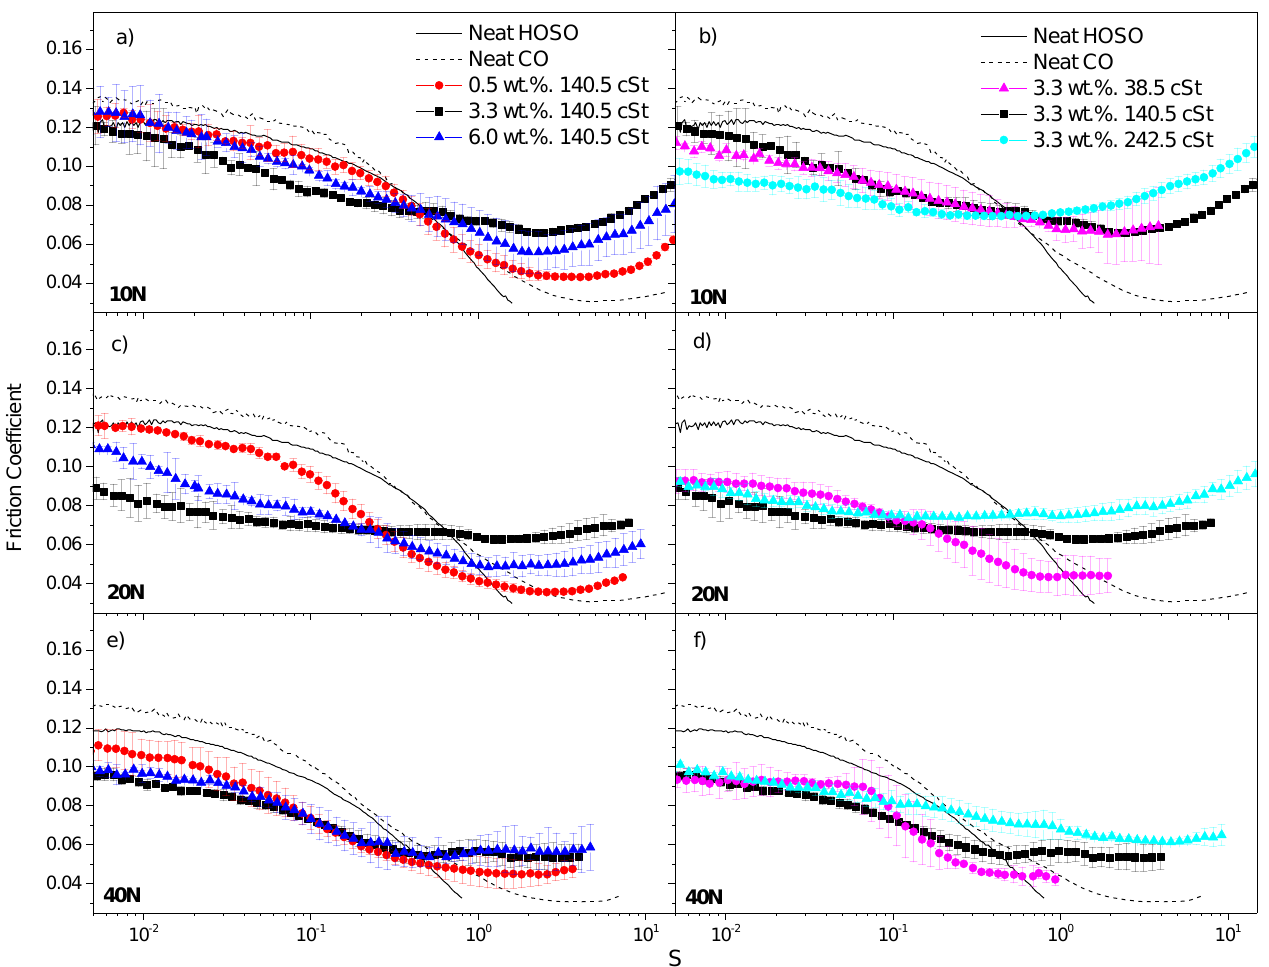
Figure 3. Stribeck curves for CNF-based dispersions, at 25 ◦ C, as a function of nanocellulose concentration ( a , c , e ) and base oil viscosity ( b , d , f ) at 10, 20 and 40 N (first, second and third rows, respectively). Neat base oils are included for the sake of comparison.